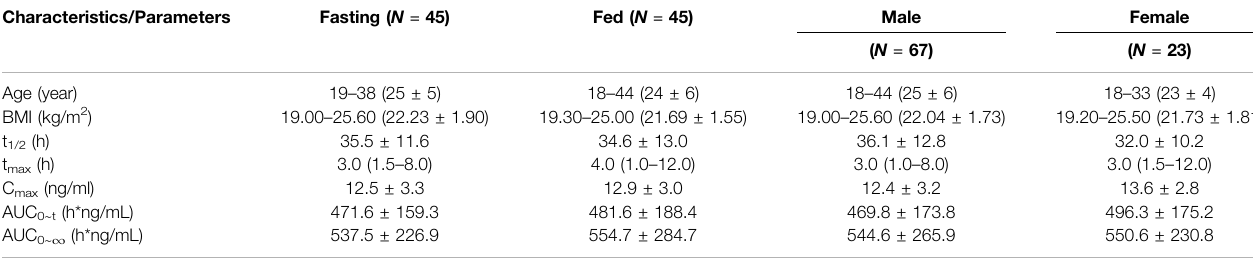
TABLE 1 | Demographic characteristics and Summary statistics for the main pharmacokinetic parameters of study subjects. Characteristics/Parameters